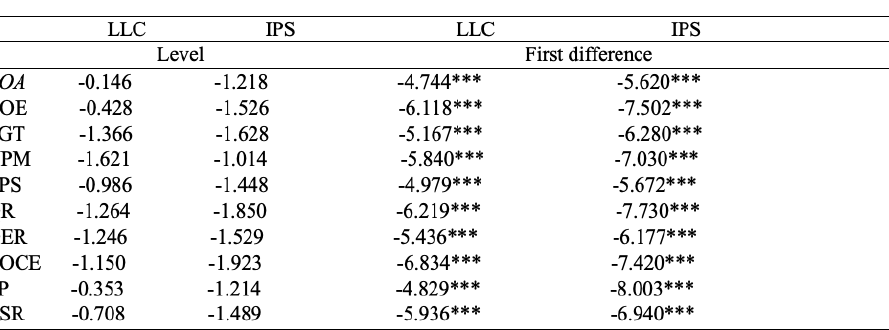
Table 2 : Panel unit root